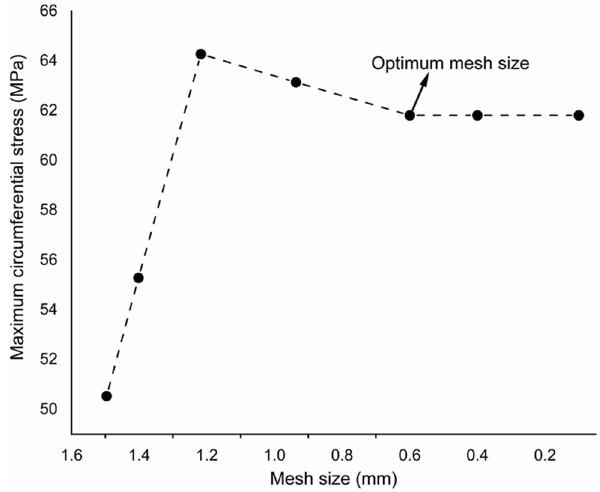
Figure 4. Mesh convergence for a braided plate with center hole.